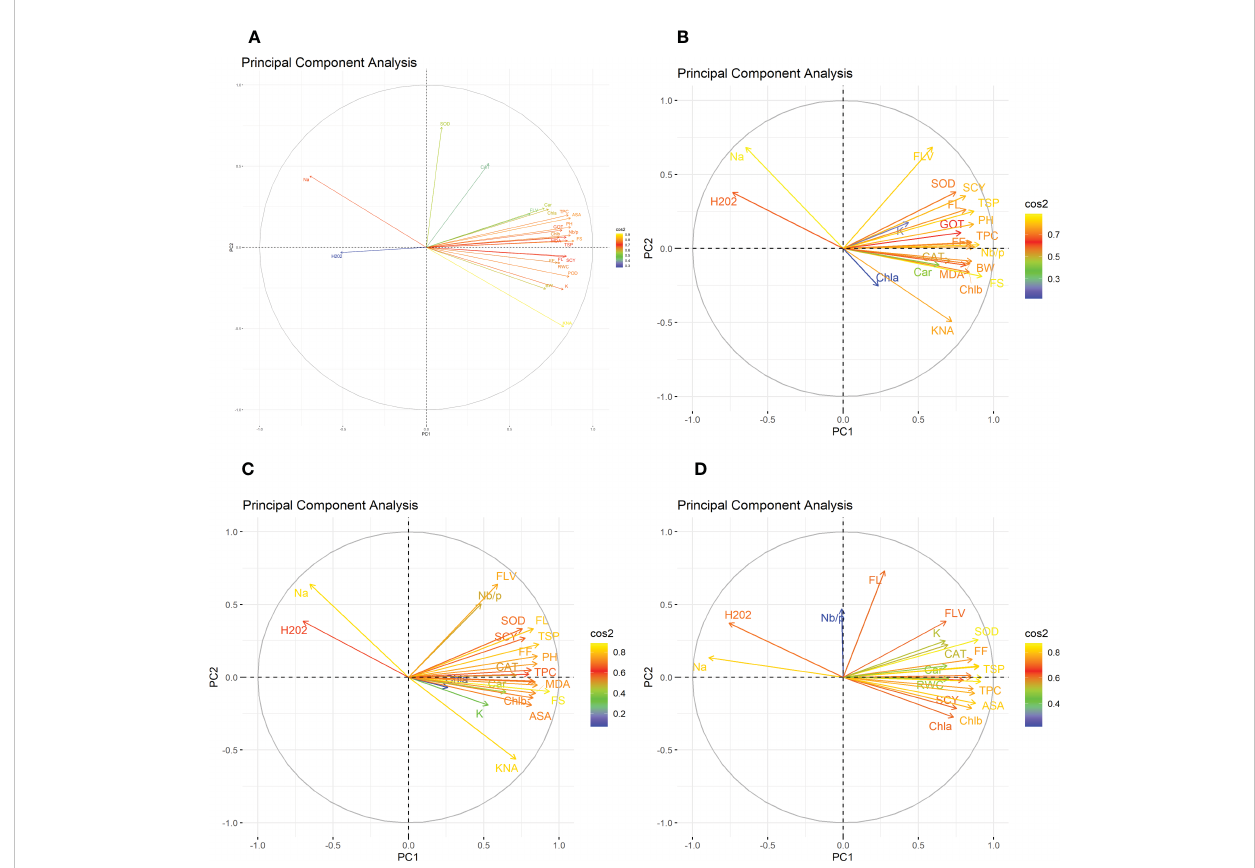
FIGURE 4 Second year heat map analysis based on mean values of various agro-physiological, biochemical, and fi ber quality traits of 30 cotton genotypes (A) control, (B) drought stress (D) , (C) heat stress (H), and (D) drought + heat stress (DH). ASA, ascorbic acid; BW, boll weight; CAR, carotenoids; CAT, catalase; Chla, Chlorophyll a; Chlb, Chlorophyll b; FF, fi ber fi neness; FL, fi ber length; FLV, fl avonoids; FS, fi ber strength; GOT, ginning out turn percentage; H202, Hydrogen peroxide; K+, potassium content; K+/Na+, the potassium over sodium ratio; MDA, malondialdehyde; Na+, the sodium contents; NBP, Number of bolls per plant; PH, plant height; POD, peroxidase; RWC, Relative water content; SCY, seed cotton yield; SOD, superoxide dismutase; TPC, total phenolic content; TSP, total soluble